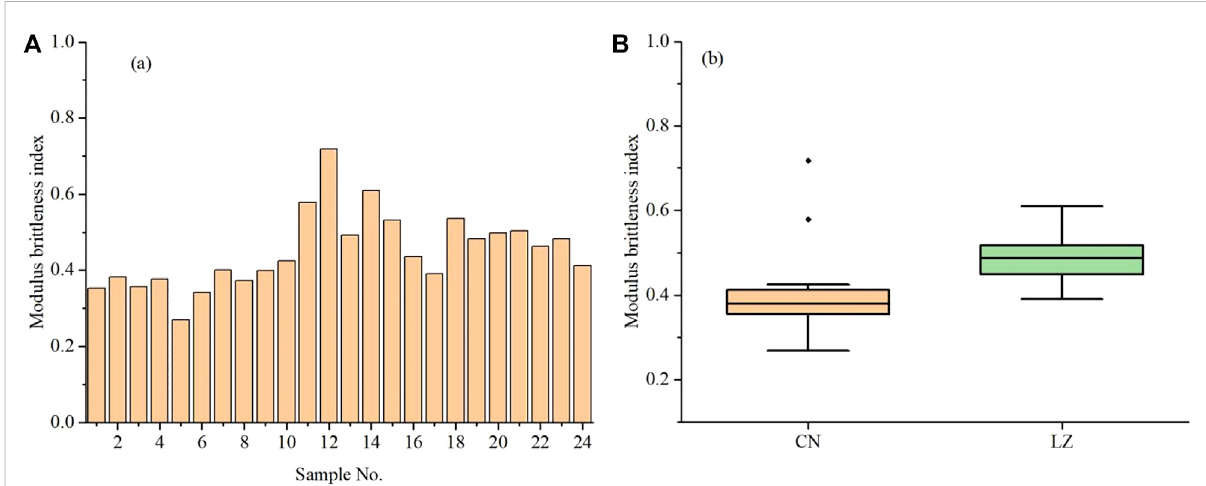
FIGURE 9 DistributionofthemodulusbrittlenessindexoftheLongmaxiFormationshaleinthestudyarea.Notes: (A) Modulusbrittlenessindexdistribution for different samples; (B) Distribution range of modulus brittleness